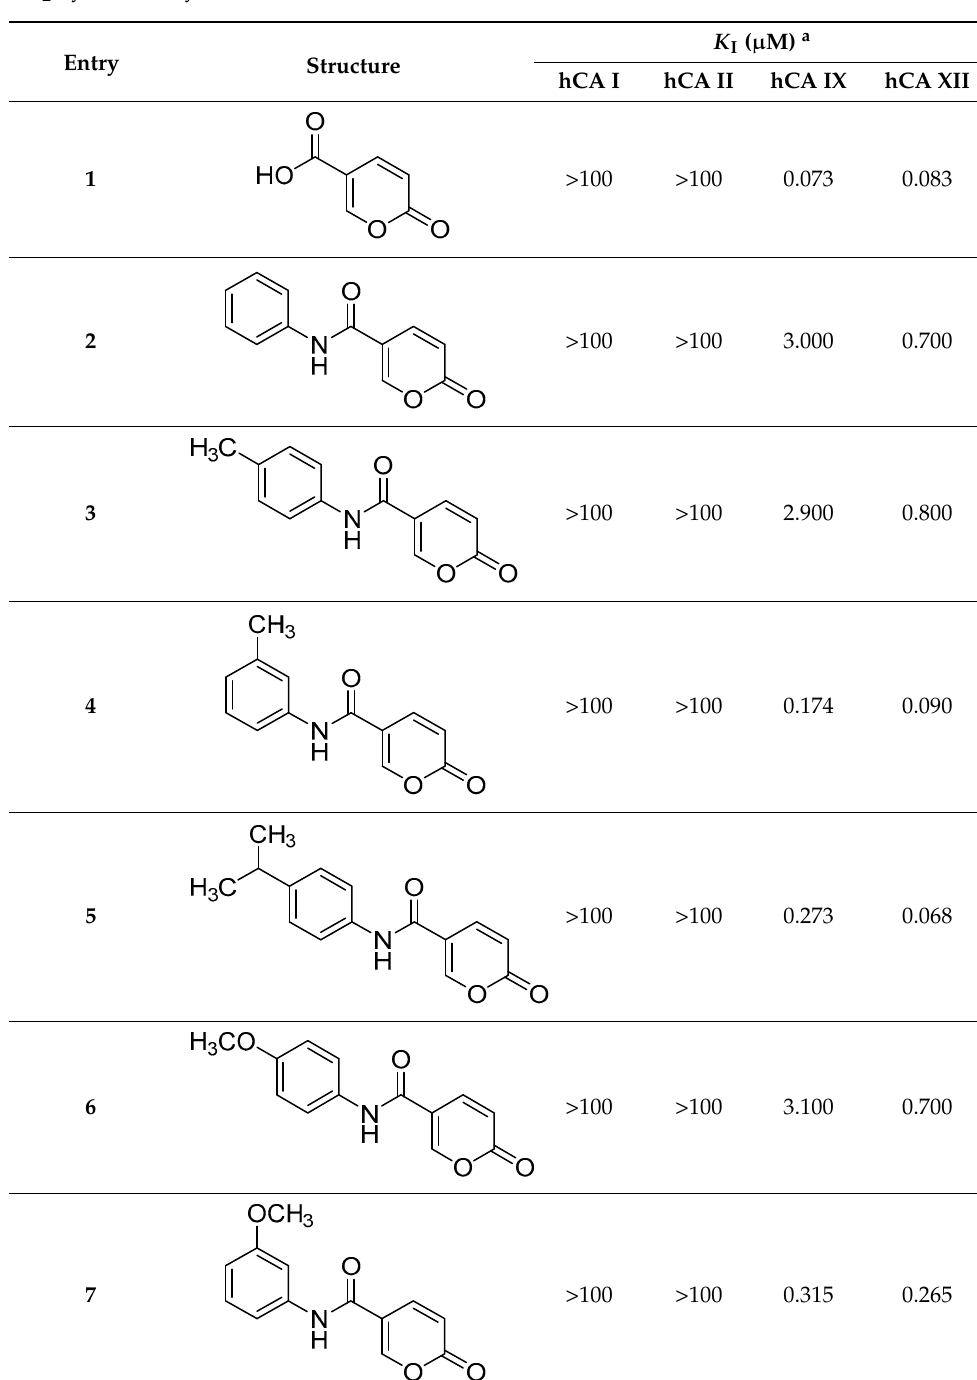
Table 1. Inhibition data against selected human CA isoforms (hCA I, II, IX, and XII) with the novel compounds 1 – 15 and the standard sulfonamide inhibitor acetazolamide (AAZ) by a stopped flow CO 2 hydrase assay.